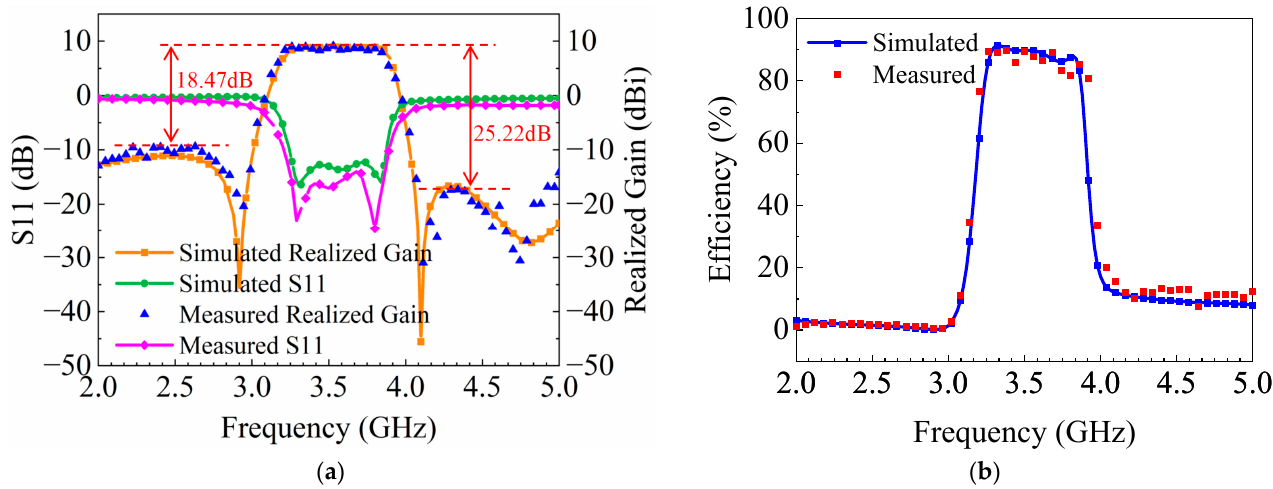
Figure 11. Simulated and measured results of the proposed antenna. ( a ) S11 and realized gain; ( b ) efficiency.